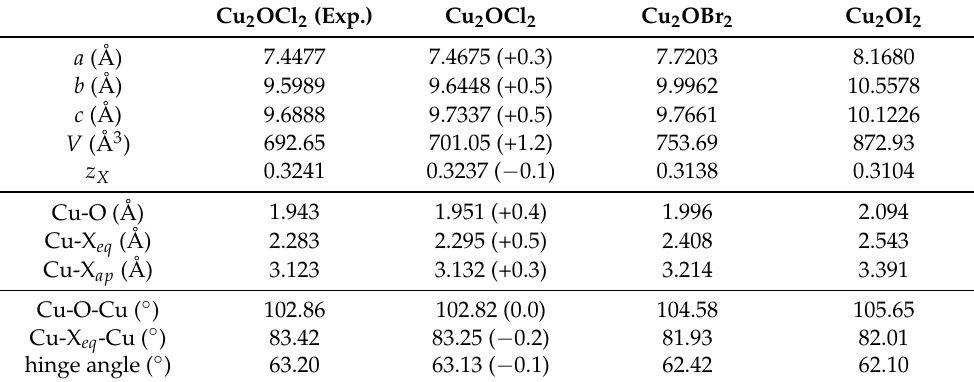
Table 1. Optimized structural parameters of the Cu 2 OX 2 compounds (X = Cl, Br, I) deduced from DFT+U calculations ( U e f f [ Cu ( 3 d )] = 6.5 eV) and experimental data of Cu 2 OCl 2 Ref. [11]. For Cu 2 OCl 2 , the deviation (in percentage) with respect to the experimental data is given in